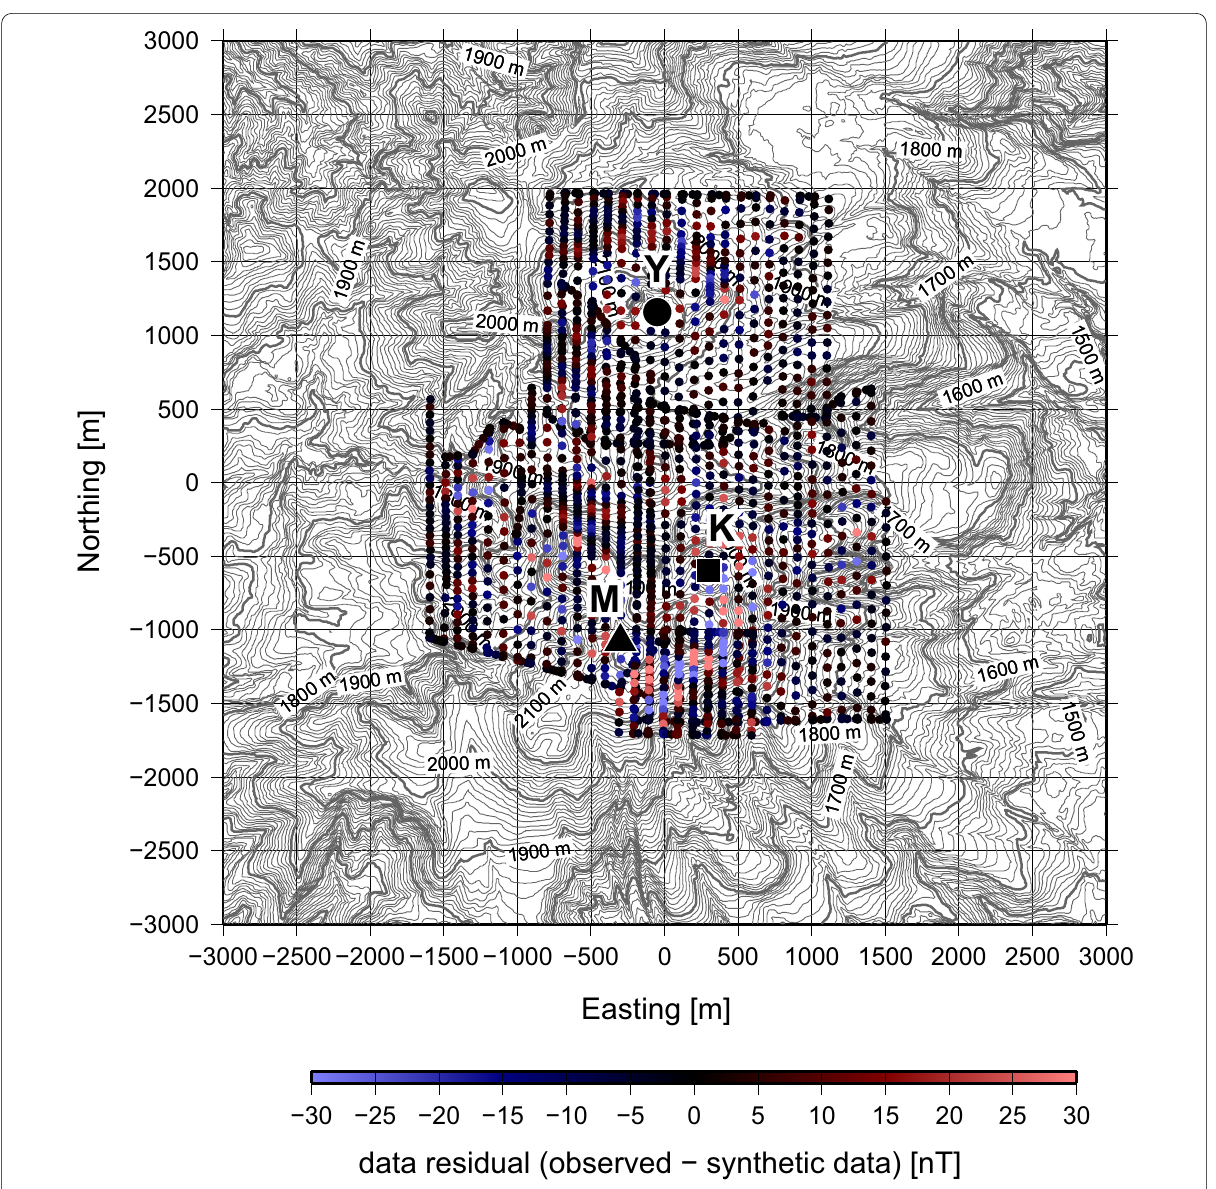
Fig. 2 Data residual between observed value and synthetic value by the optimal magnetization intensity model in Fig. 3. Standard deviation of data misfit is estimated as 12.7 nT. The closed circle with “Y”, square with “K”, triangle with “M” are the crater lake Yugama of Mt. Shirane, Kagamiike-kita crater, and the main crater of Mt. Motoshirne,